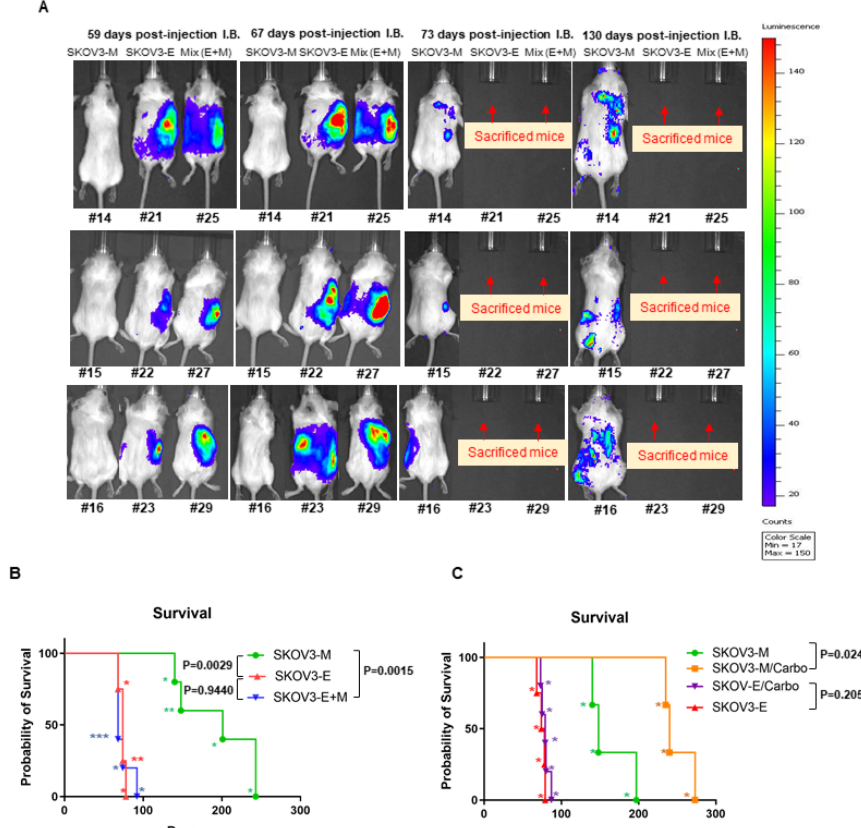
Figure 1. In vivo examination of tumor initiation, spreading, survival and response to treatment in SCID mice IB-injected with SKOV3-M SKOV3-E and SKOV3-E+M cells. ( A ) Whole body representative bioluminescence images of the emerging tumors and metastatic lesions in SCID mice 59 days, 67 days, 73 days and 130 days post-injection IB of SKOV3-M, SKOV3-E and SKOV3-E+M cells. ( B ) Survival plots for phase 1 mice IB-injected with SKOV3-M, SKOV3-E and Mix cells. ( C ) Survival plots for phase 2 mice IB-injected with SKOV3-M and SKOV3-E cells, followed by treatment with carboplatin. Asterisks represent the number of sacrificed mice at each step according to the survival time, as indicated in Table 1; see also Section 4.3.5 for details.